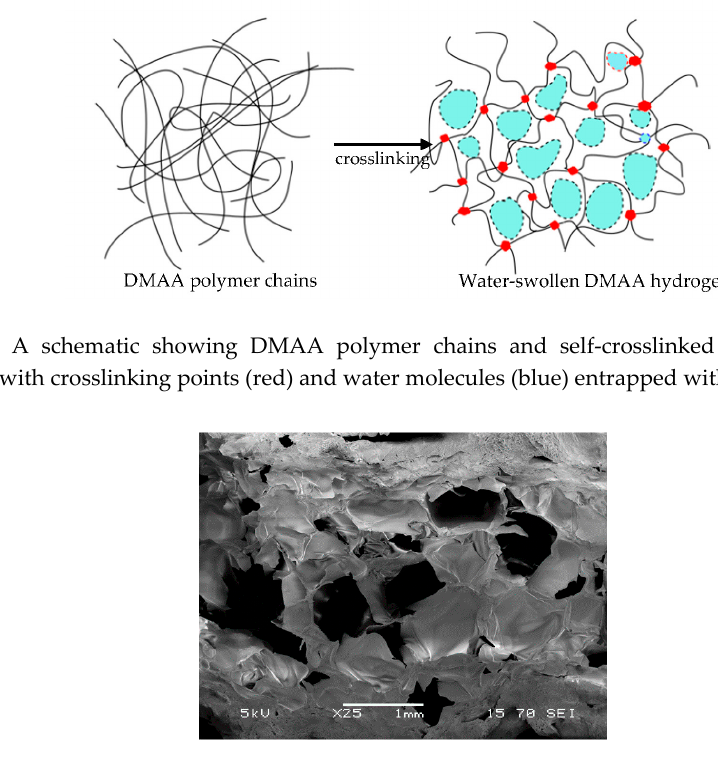
Figure 3. Scanning electron micrograph of DMAA hydrogel showing large pores in the network.